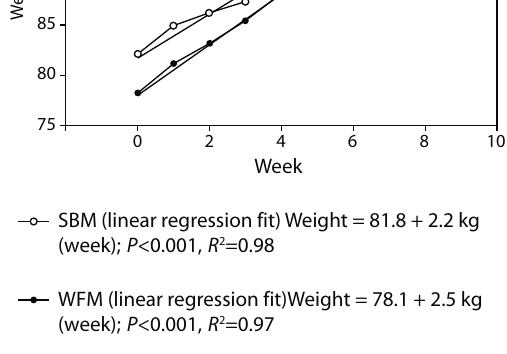
Fig. 2. Weekly live weight gain (mean values and fitted regression lines) for reindeer steers and females from two different feeding treatments; SBM (feed mixture based on soybean meal protein; n =7, 3 females and 4 steers) and WFM (feed mixture based on fish meal protein; n =6, 3 females and 3 Table 4. Weight gain, dry matter intake and feed conversion efficiency (least-squares means ± standard errors) for rein- deer steers and females from two different feeding treatments; SBM (feed mixture based on soybean meal protein) and WFM (feed mixture based on fishmeal protein) during the 8 weeks performance trial. Trait